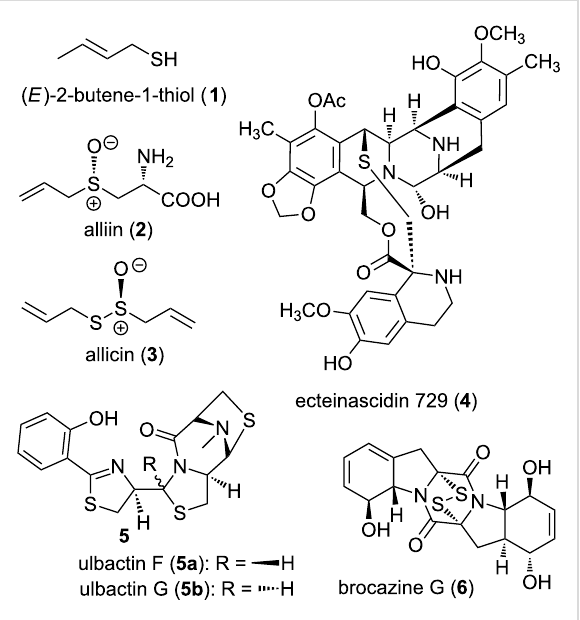
Figure 1: Some sulfur-containing natural products.